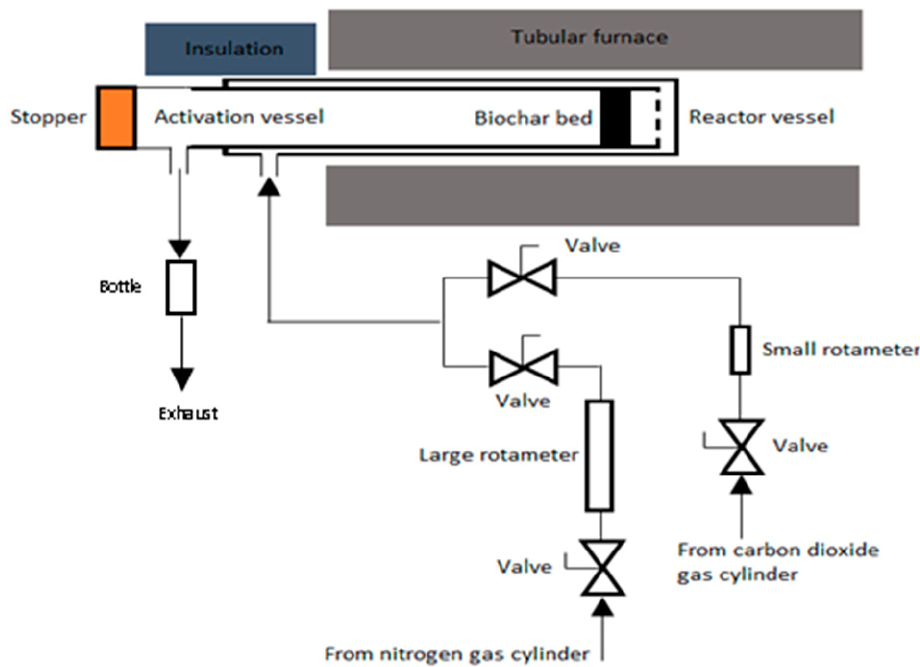
Figure 3. Experimental set-up for carbon-based materials physical activation.